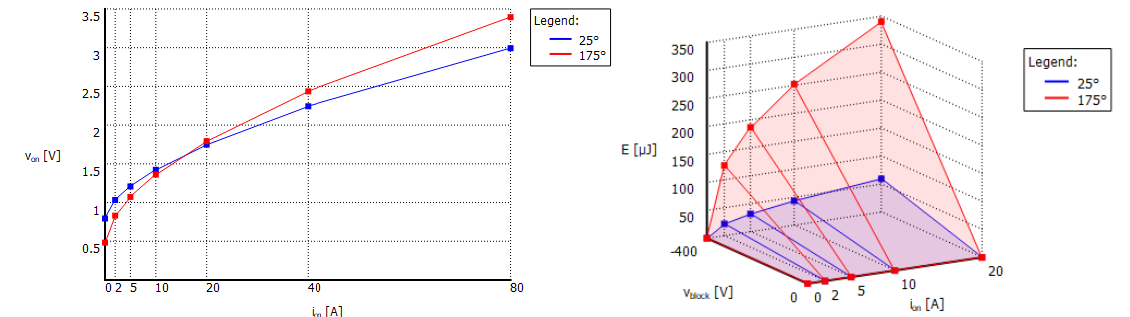
Figure 7. Diode thermal loss description, conduction and turn-off losses.